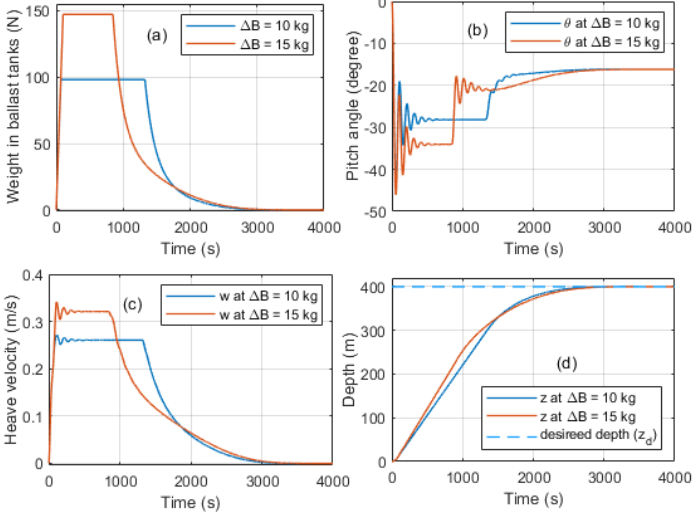
Figure 18. ( a ) Variation of the weight vs. time in ballast tanks, ( b ) pitch angle with time, ( c ) sinking (heave) velocity with time and ( d ) depth with time in closed loop for 5 m length AUV.